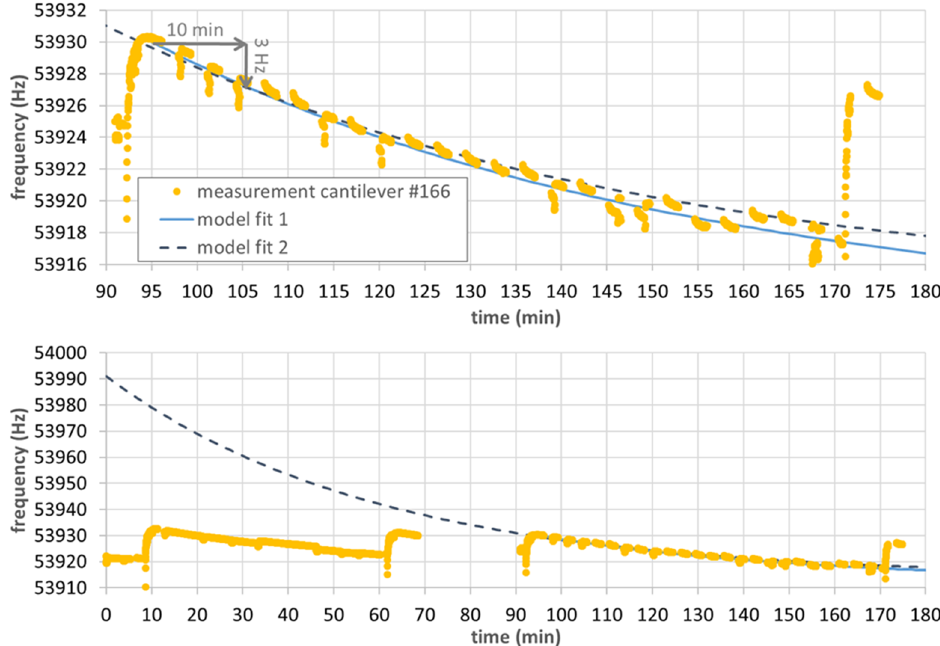
Figure 13. Frequency response of #166 functionalized microcantilever at 27 °C and 970 mbar exposed to 100 scc/min of air with a vapor concentration of 190 ppmV with two different model fittings both according to approach 1 Equation (2). Top : model fit 1 assuming a complete degassing of MCM-48 at t 0 = 93 min. Bottom : model fit 2 assuming a complete degassing of MCM-48 a t 0 = 0